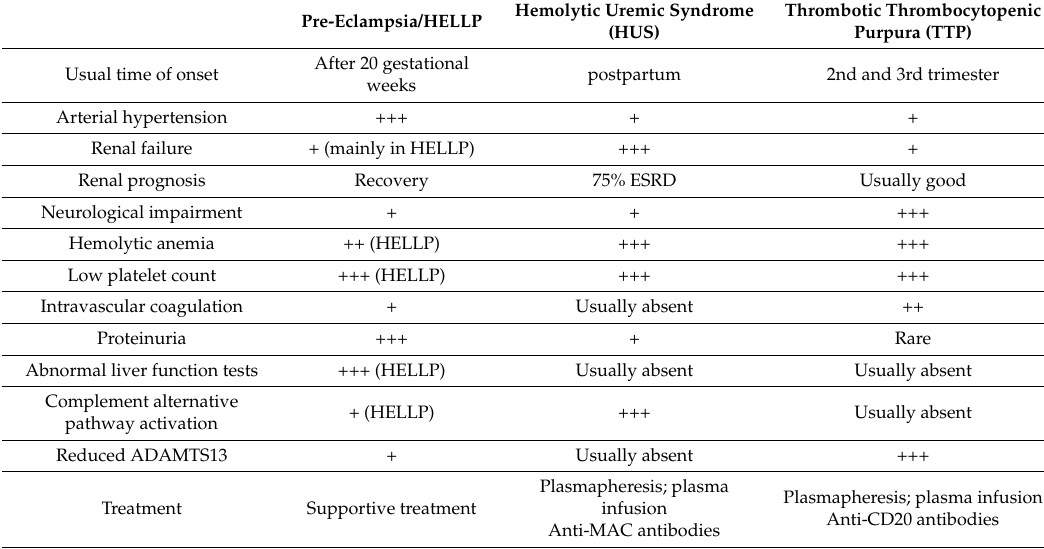
Table 3. The differential diagnosis of disorders associated with AKI and thrombocytopenia in pregnancy (modified from